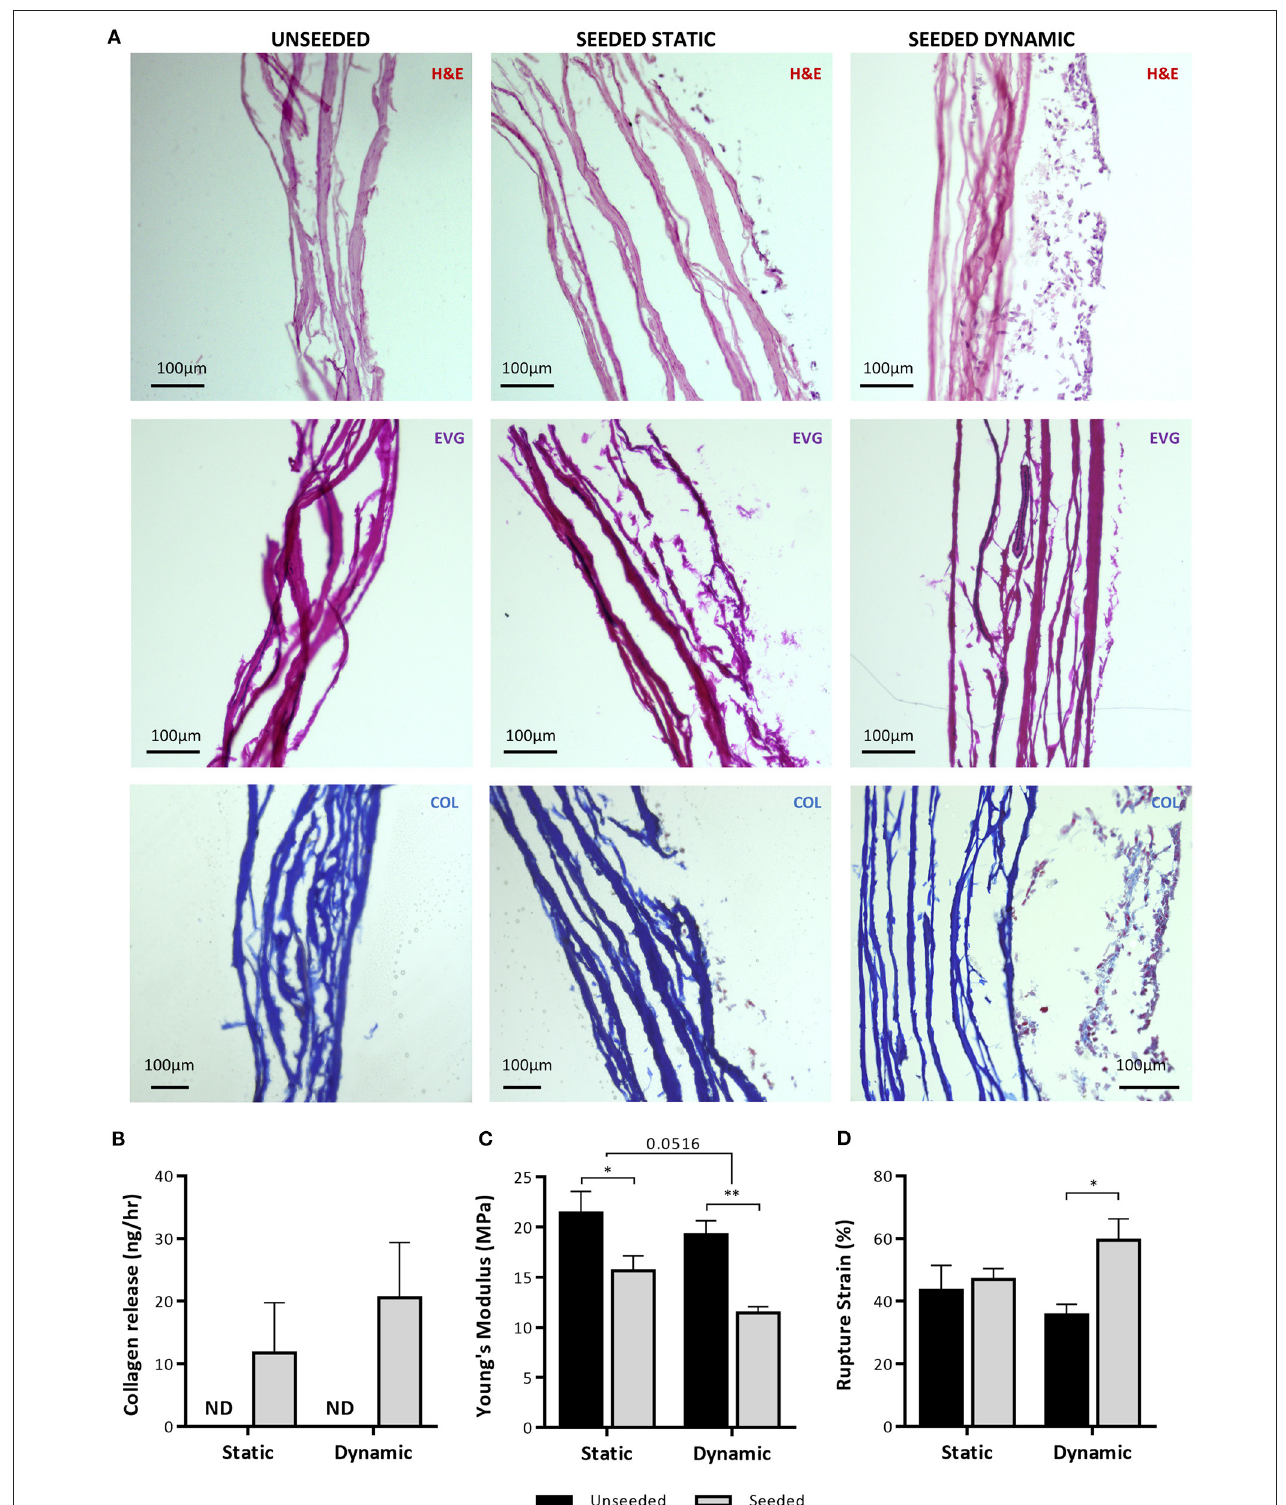
FIGURE 9 | Analysis of NG2 UCP engineered graft structure and properties. (A) Representative images of hematoxylin and eosin staining (H&E), elastin van Gieson staining (EVG) and Mallory’s trichrome collagen staining (COL) of NG2 UCP seeded CorMatrix grafts. (B) Quantification of Pro-Collagen 1 a1 in CM. (C) Quantification of Young’s Modulus. (D) Quantification of rupture strain. Static = 5 days static conditioning, dynamic = 5 days static plus 7 days dynamic conditioning. Data represent means ( ± S.E.M). Unseeded n = 3, and seeded n = 4 biological replicates. * p < 0.05 and ** p < 0.01.